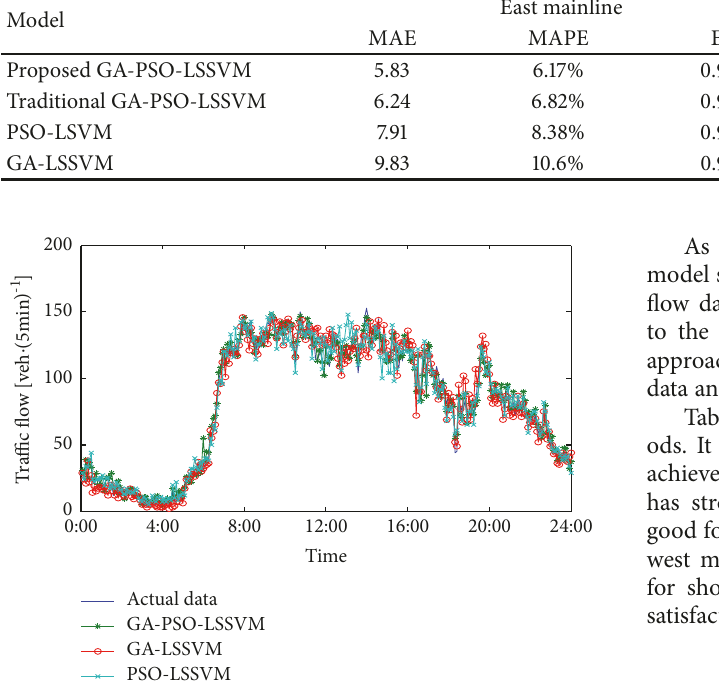
instructs that the proposed approach is able to predict short- term traffic flow data with small errors in most